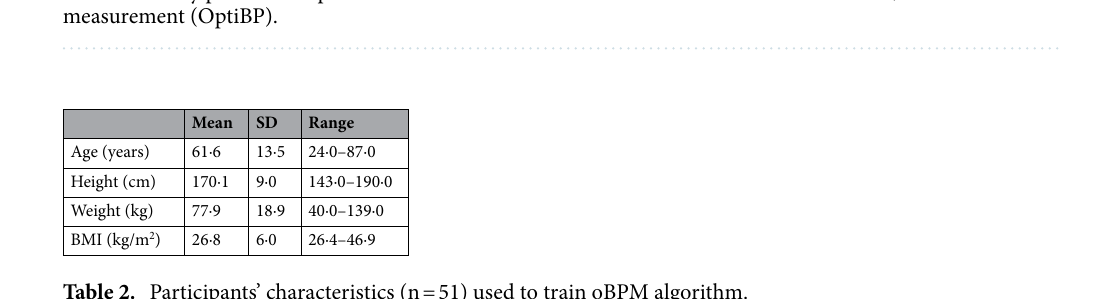
Table 2. Participants’ characteristics (n = 51) used to train oBPM algorithm.